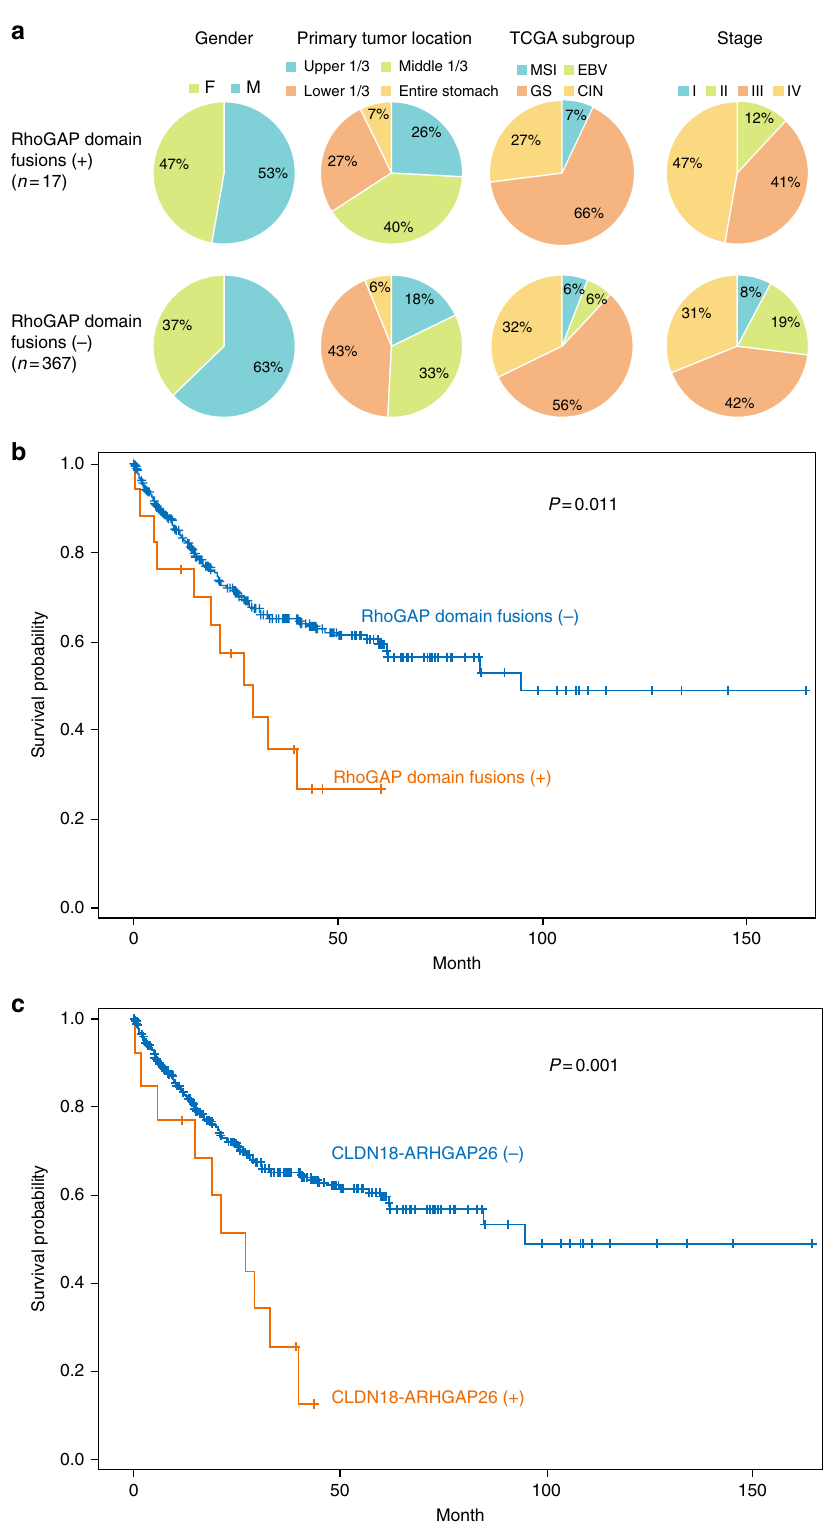
Fig. 4 Clinical implications of RhoGAP domain-containing fusions in the expanded dataset (n = 384) ( a ) Clinicopathological characteristics (gender and primary tumor location) and TCGA subgroups in patients with (upper row) and without (lower row) RhoGAP domain-containing fusions. ( b ) Kaplan-Meier curves for the overall survival of patients with DGCs expressing three recurrent RhoGAP domain-containing fusions (n = 17) and those without (n = 367). ( c ) Kaplan-Meier curves for the overall survival of patients with DGCs expressing the CLDN18-ARHGAP26 fusion (n = 13) and those without (n =